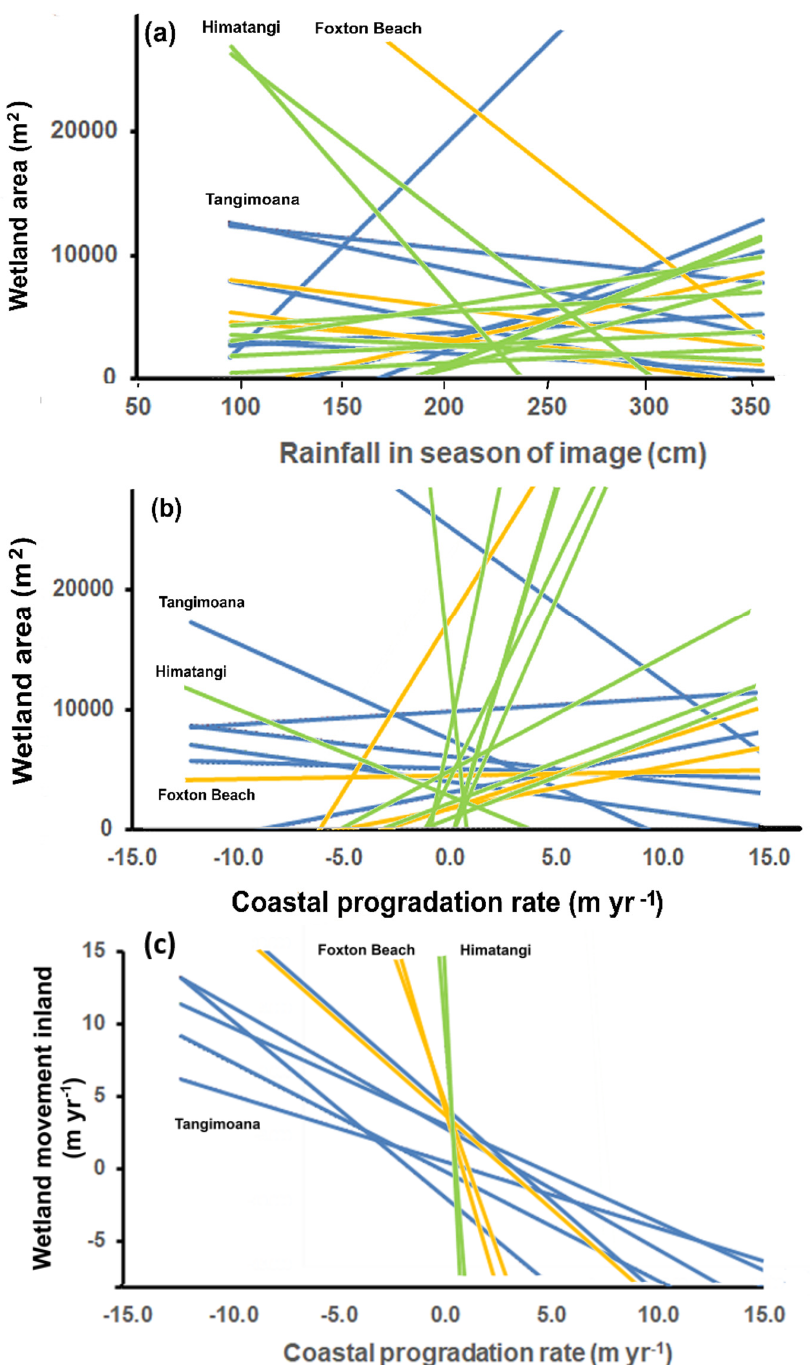
Figure 9. Fitted lines, colour-coded by study site, for the relationship between ( a ) the area of each wetland and rainfall in the season of the image, ( b ) area and coastal progradation rate over the period before the image, and ( c ) coastal progradation rate against rate of wetland movement